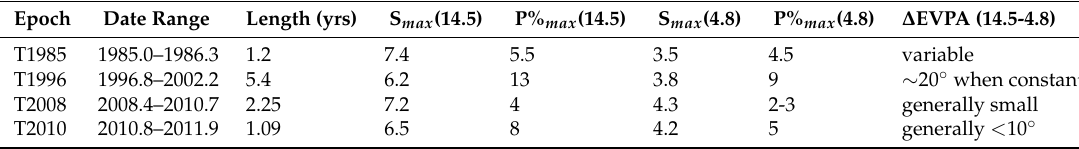
Table 3. Summary of observed emission properties during modeled